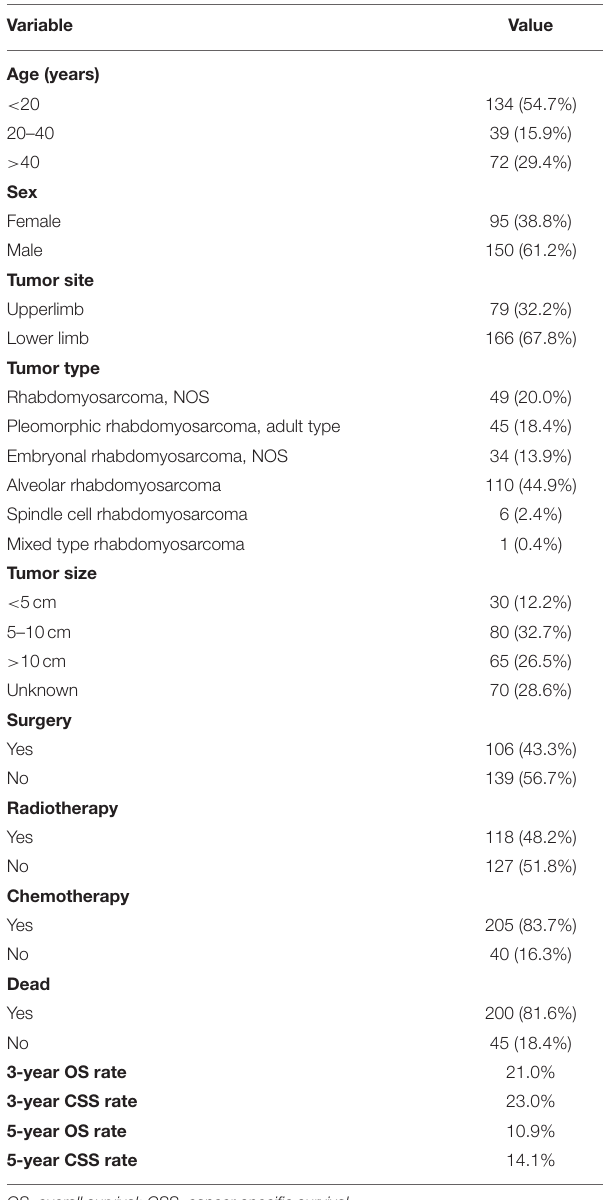
TABLE 1 | Baseline characteristics of 245 patients with limb rhabdomyosarcoma and metastasis at diagnosis.